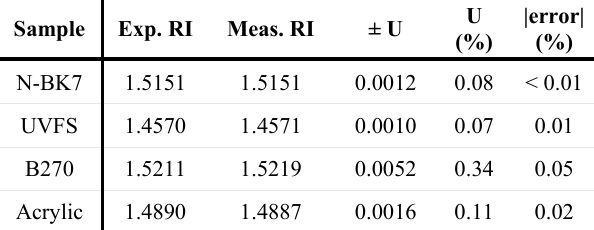
Table 1. System results of measurements of the RI to four samples: N-BK7 and UVFS (calibration) and B270 glass and a piece of a block of